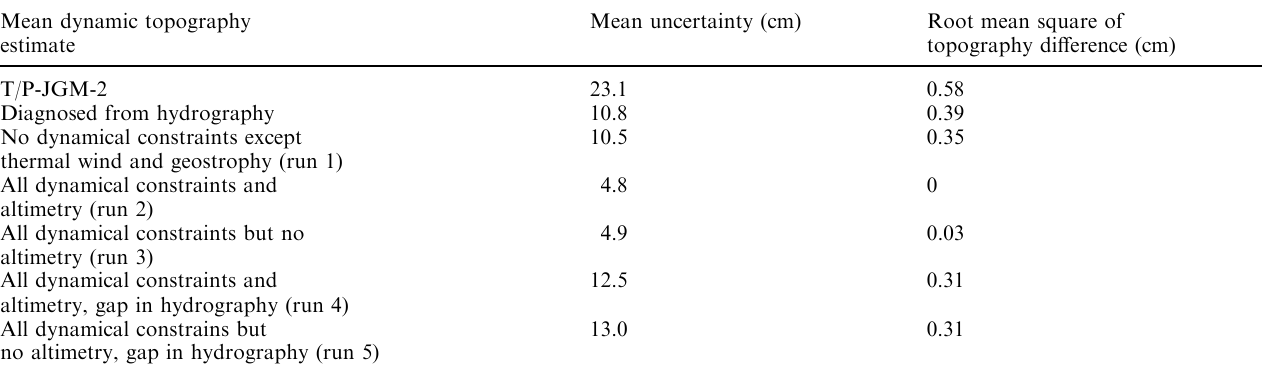
Table 1. Column 1: mean uncertainty in the various estimates of the mean dynamic topography (5 (cid:176) (cid:180) 4 (cid:176) grid) presented in this paper. Column 2: root mean square of the di(cid:128)erence between the 5 (cid:176) (cid:180) 4 (cid:176) dynamic topography estimate using the dynamical and the